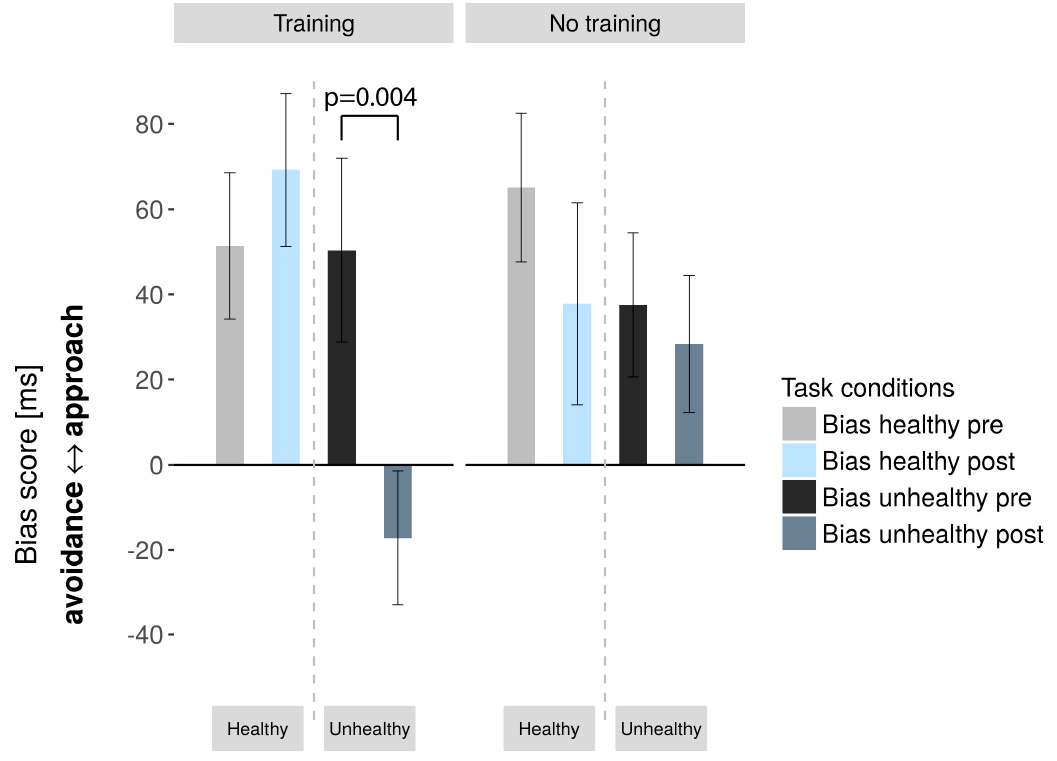
Figure 2. Bias scores in the training and sham-training groups pre- and post-training (error bars: standard error of the mean). We observed a significant three-way interaction between group, time, and image category.